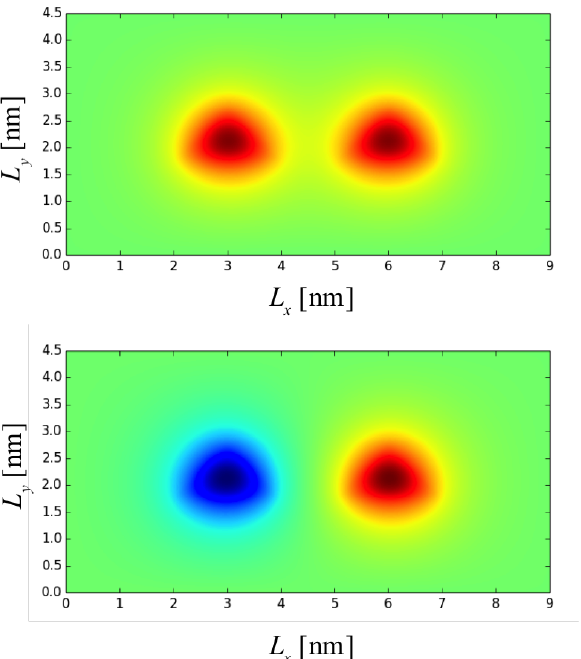
Figure 2. The wavefunction of MoS 2 DQD with QD base length b = 2.0 nm and inter-QD distance d = 3.0 nm. ( top ) bonding state and ( bottom ) anti-bonding